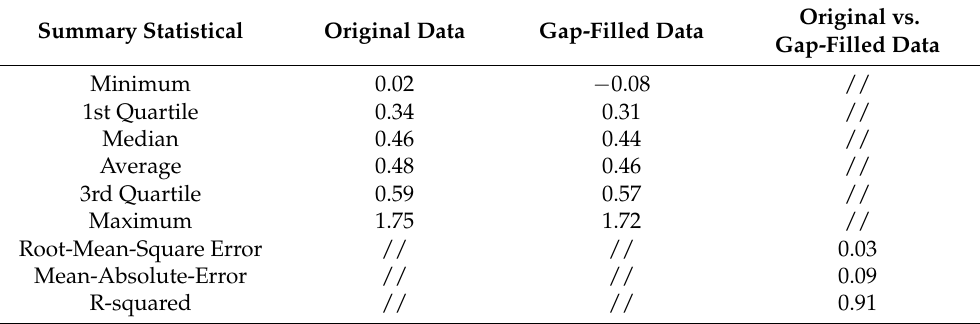
Table 4. The statistical parameters of the original and gap-filled data pixels (//–not